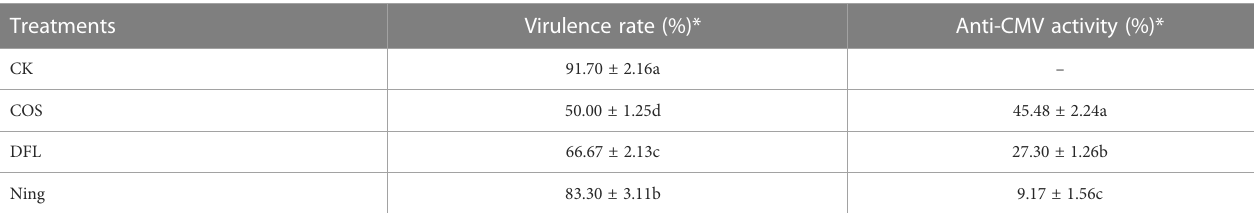
TABLE 1 Results of Laboratory Anti-CMV Activity of COS, DFL, and Ning.